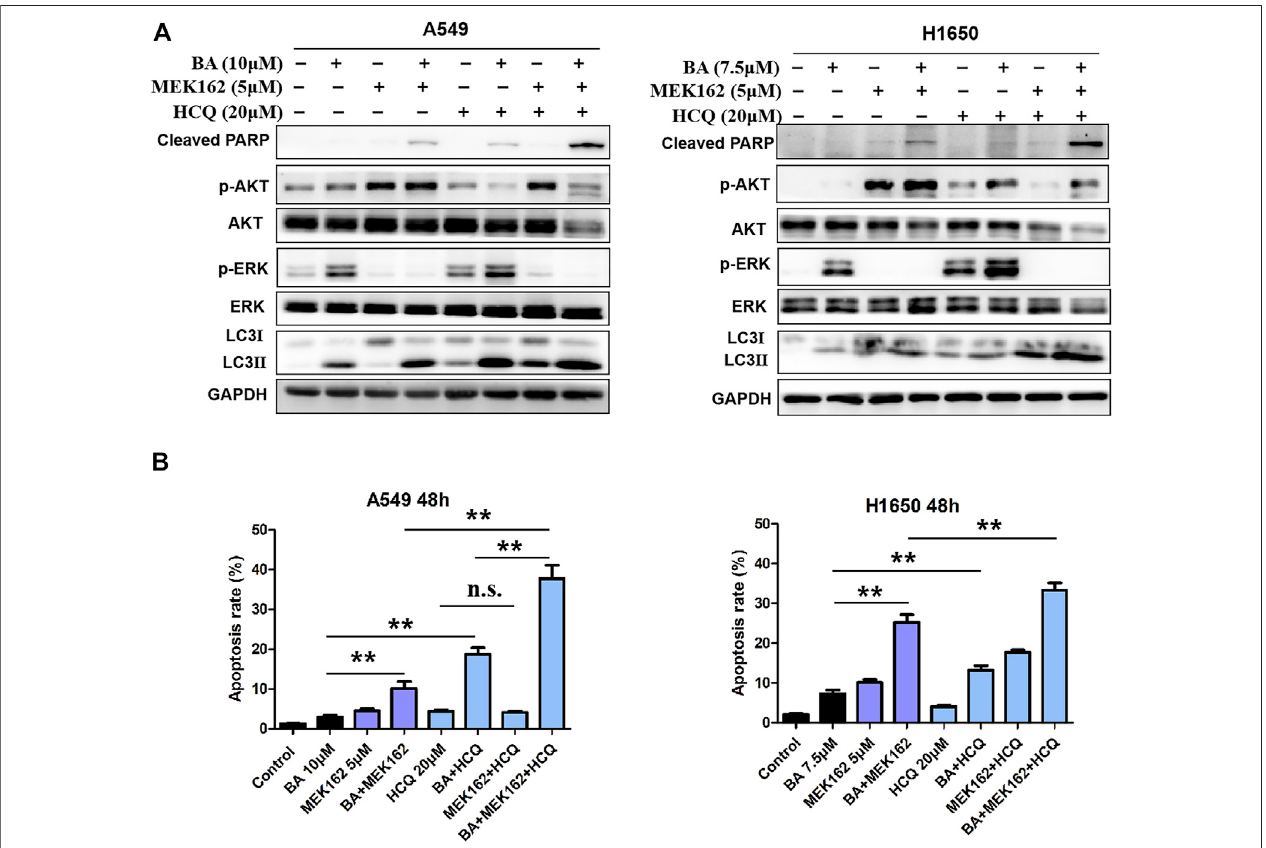
FIGURE 8 | Triple-drug therapy enhances therapeutic activity in vitro . (A) A549 and H1650 cells were treated with indicated concentrations of BA alone or in combinationwith5 μ MMEK162,orincombinationwithMEK162plus20 μ MHCQfor48 h,andthelevelsofAKT,p-AKT,LC3,cleavedPARP,ERK,andp-ERK1/2were determined by Western blots. (B) A549 and H1650 cells were treated with indicated chemicals alone or in combination for 48 h, and apoptosis wasdetected using fl ow cytometry. ** p < 0.01. ns, no signi fi cant